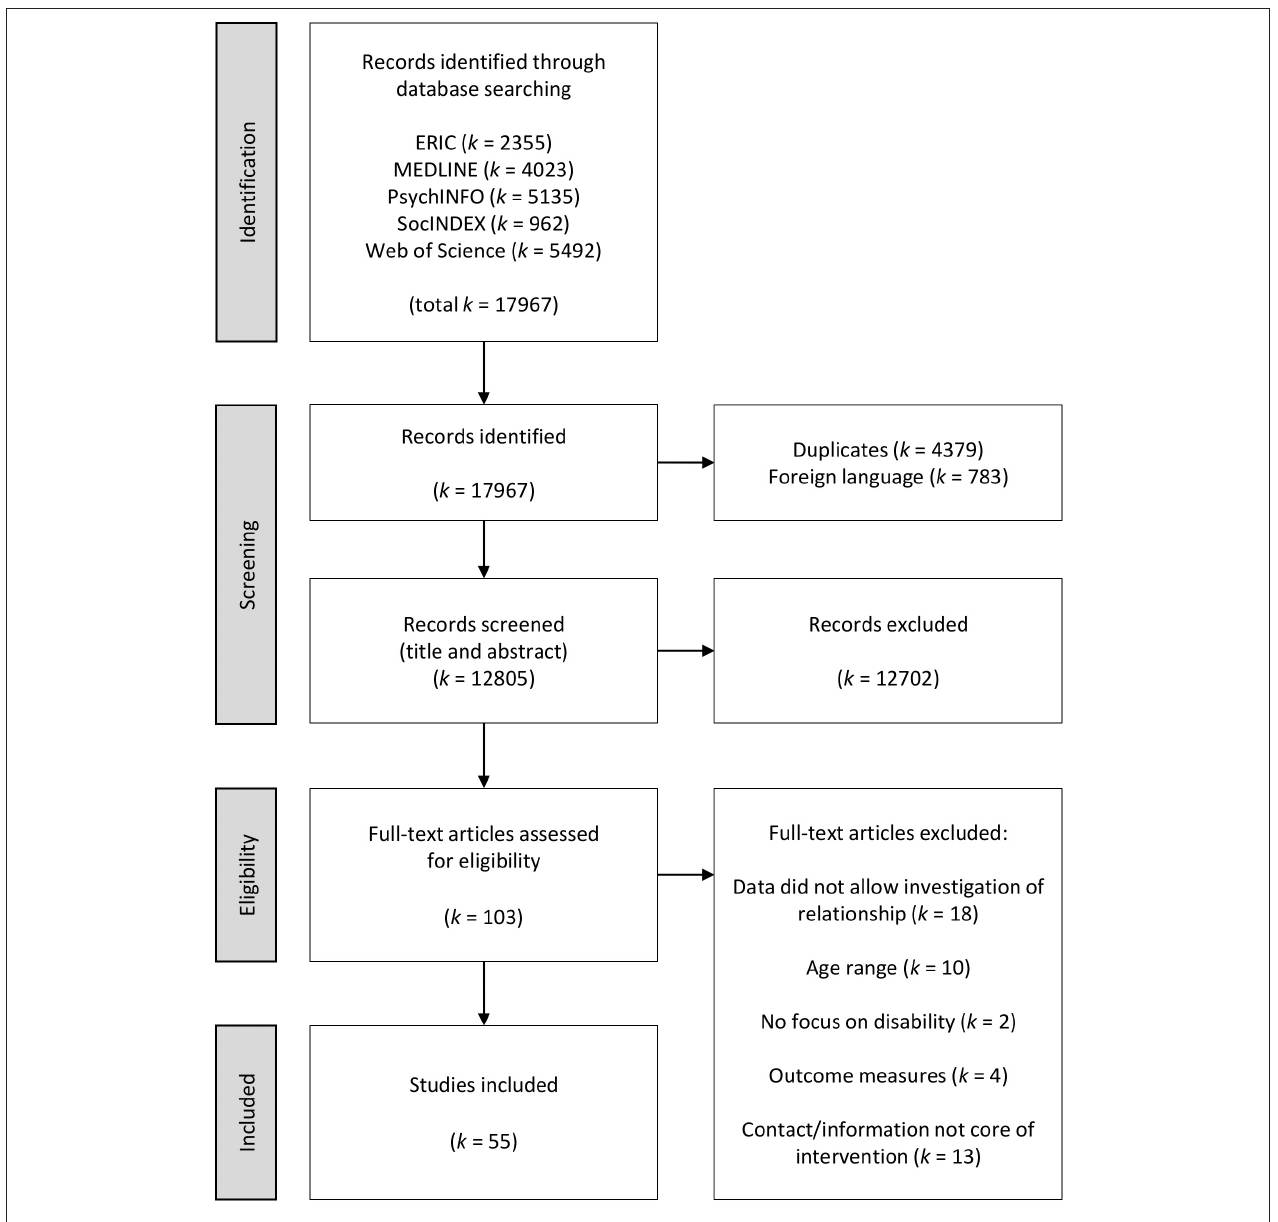
FIGURE 2 | Flowchart of the selection